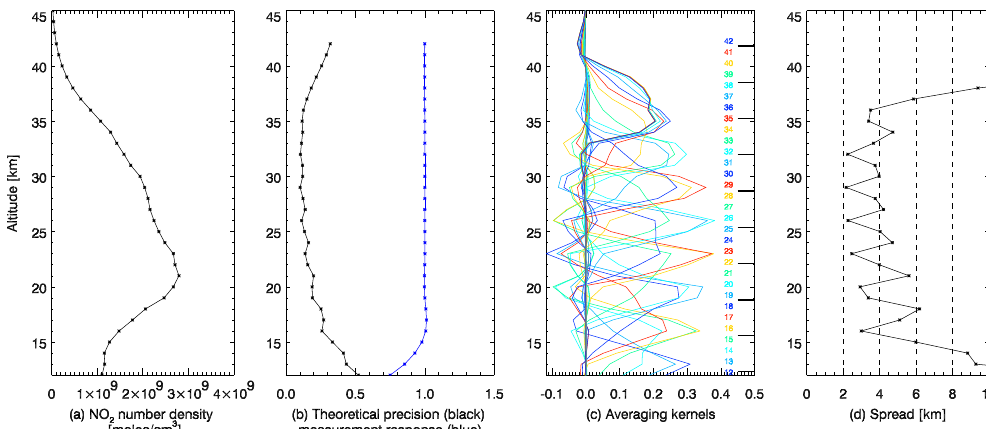
Fig. 1. An example retrieval at about 77.5 ◦ N (measurement performed on 18 June 2005) is analyzed to study the sensitivity. The retrieved NO 2 profile is shown in panel (a) . Panel (b) shows the theoretical precision (black), as well as the measurement response (blue). Panel (c) displays the respective averaging kernels, color coded for altitude levels. Panel (d) shows the spread of the averaging kernels. Averaging kernels, theoretical precisions and measurement response are dimensionless